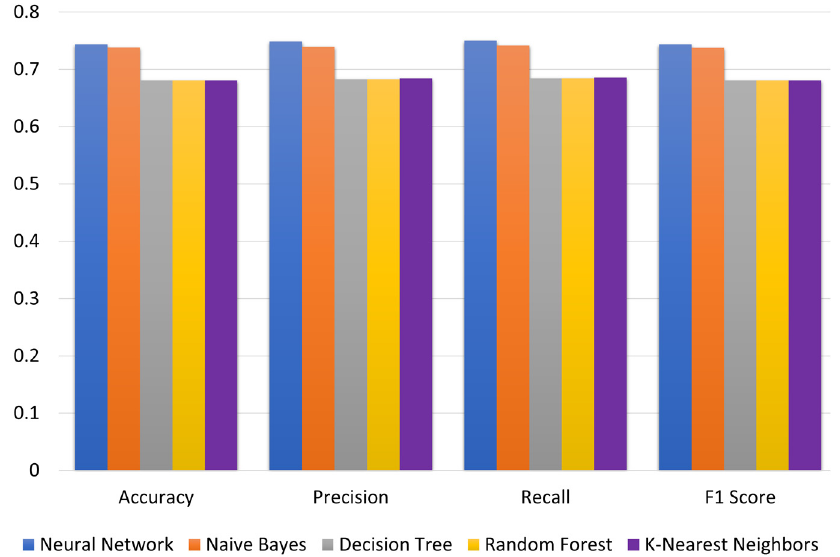
Figure 3. Model comparison for different techniques based on optimized admission scores (ASO). Table 3. Evaluation metrics for all models using current and optimized admission scores.